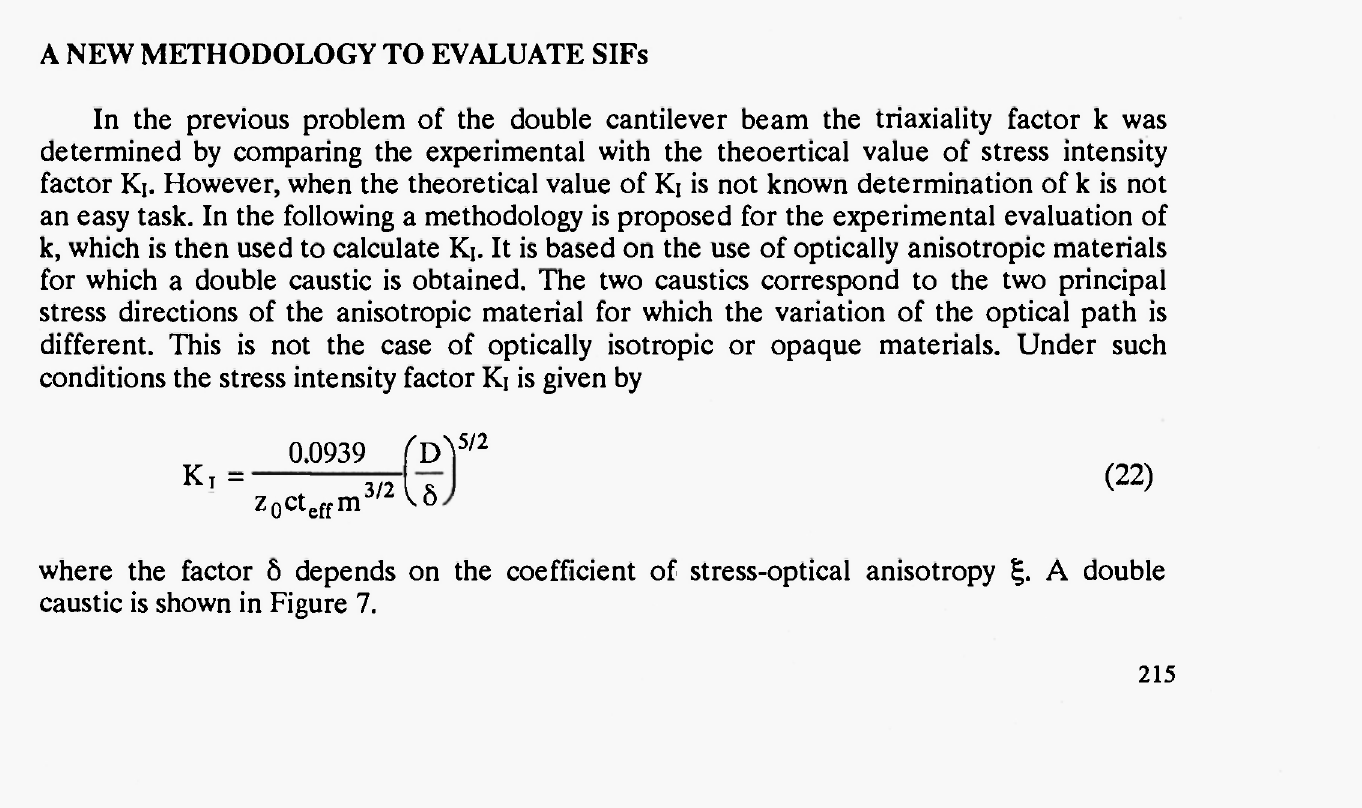
Figure 6 Variation of the triaxiality factor k versus ro/t for specimen thickness t=12.5